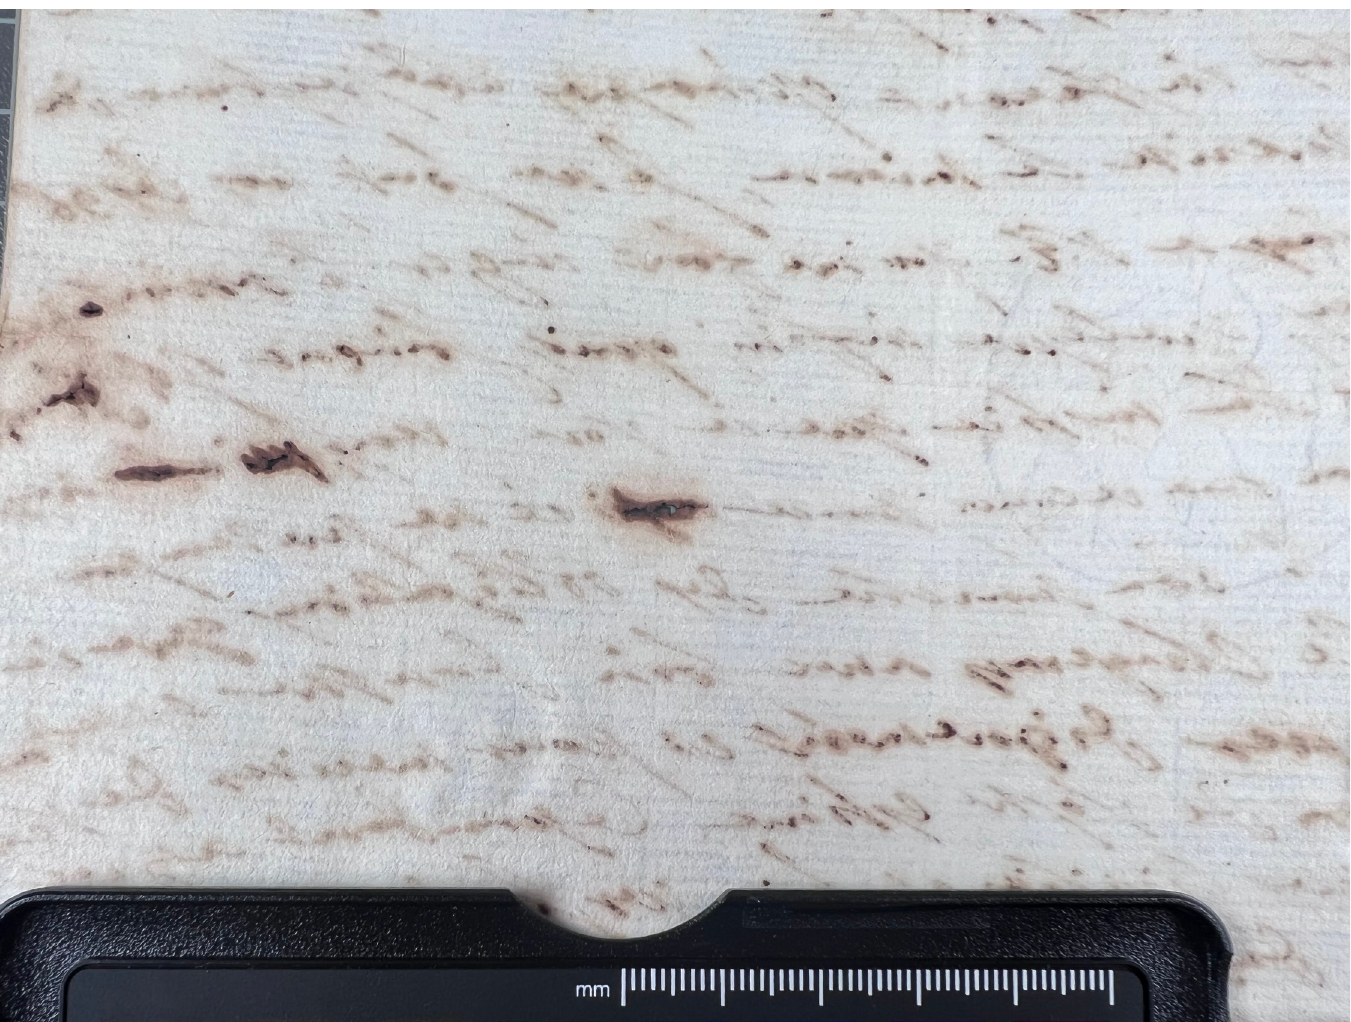
Fig 3. Burn through category 3. Example of document from the Azzolino collection displaying burn through 3 from